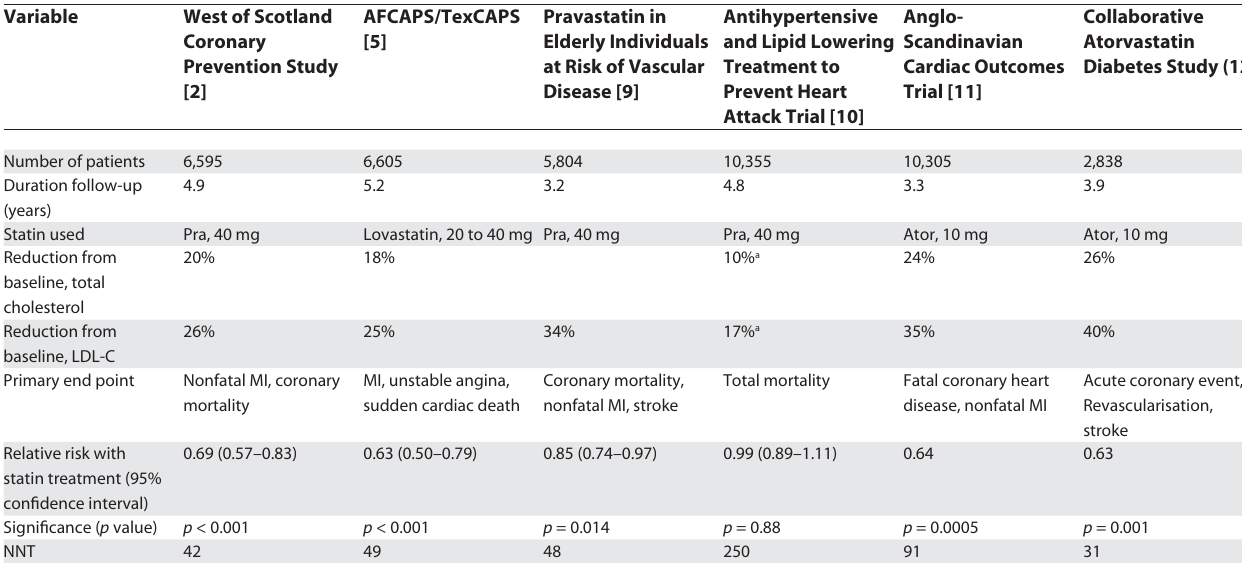
Table 2. Placebo-Controlled Primary Prevention Statin Trials